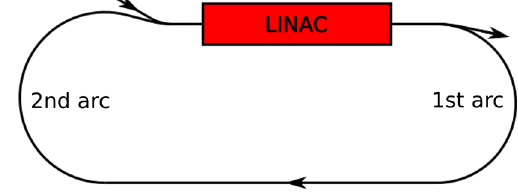
FIG. 2. Layout of the double-pass recirculating proton linac